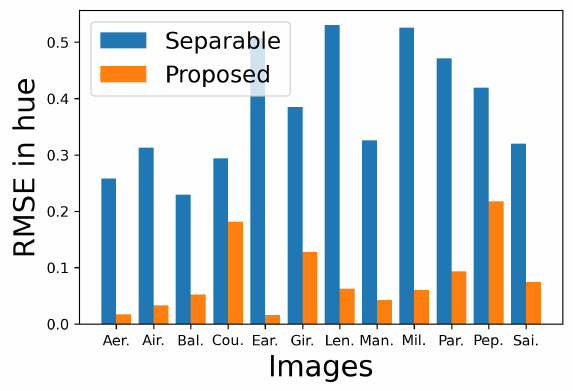
Figure 26. Comparison of the RMSE of hue of the images in Figures 24 and 25 from the original images.